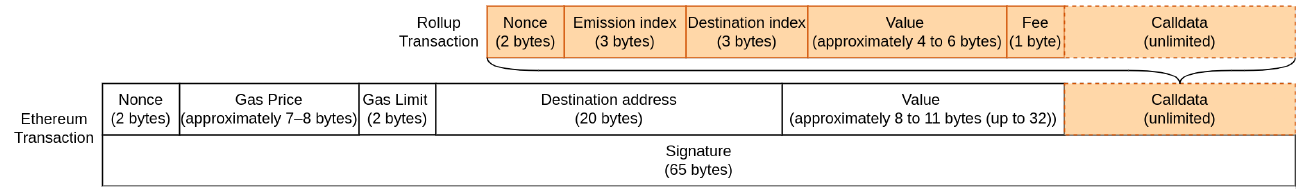
Figure 3. Integration of a rollup transaction into an Ethereum transaction.